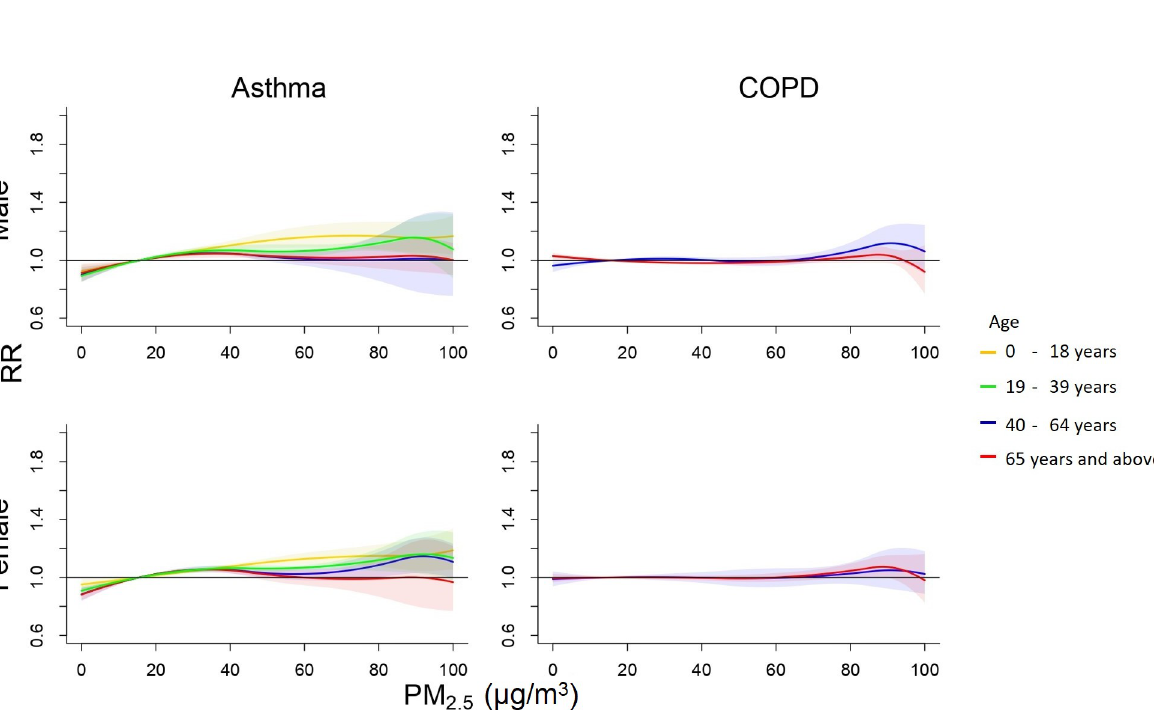
PLOS ONE | https://doi.org/10.1371/journal.pone.0253814 July 6, 2021 8 /